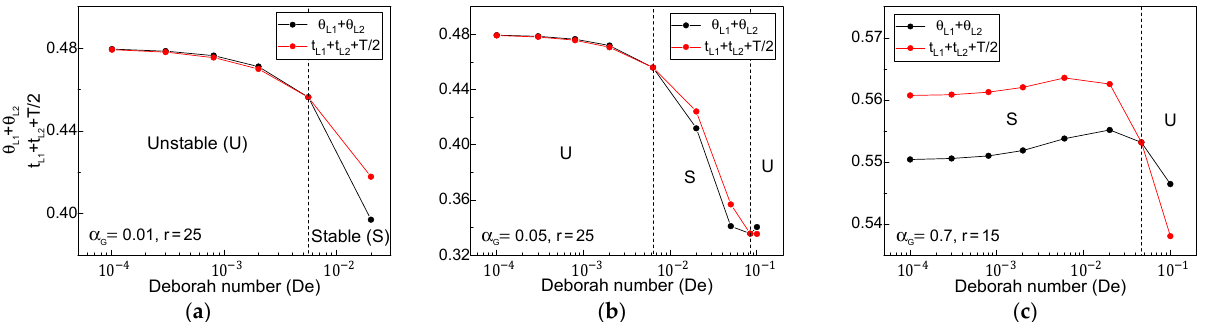
Figure 5. Changes in time scales of left-hand side (LHS) and right-hand side (RHS) of the simple indicator: ( a ) α G = 0.01, r = 25, ( b ) α G = 0.05, r = 25, and ( c ) α G = 0.7, r = 15. Here, θ L 1 and θ L 2 represent the dimensionless traveling times of the maximum and minimum cross-sectional area waves; t L 1 and t L 2 are the dimensionless traveling times of the unity-throughput waves; T is the dimensionless period of oscillation.